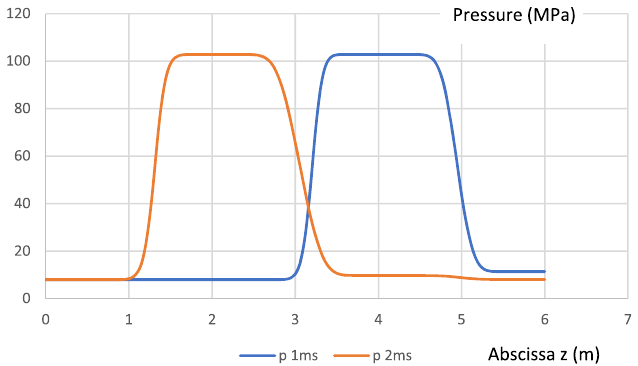
Fig. 15. Steam explosion: pressure pro fi les in the